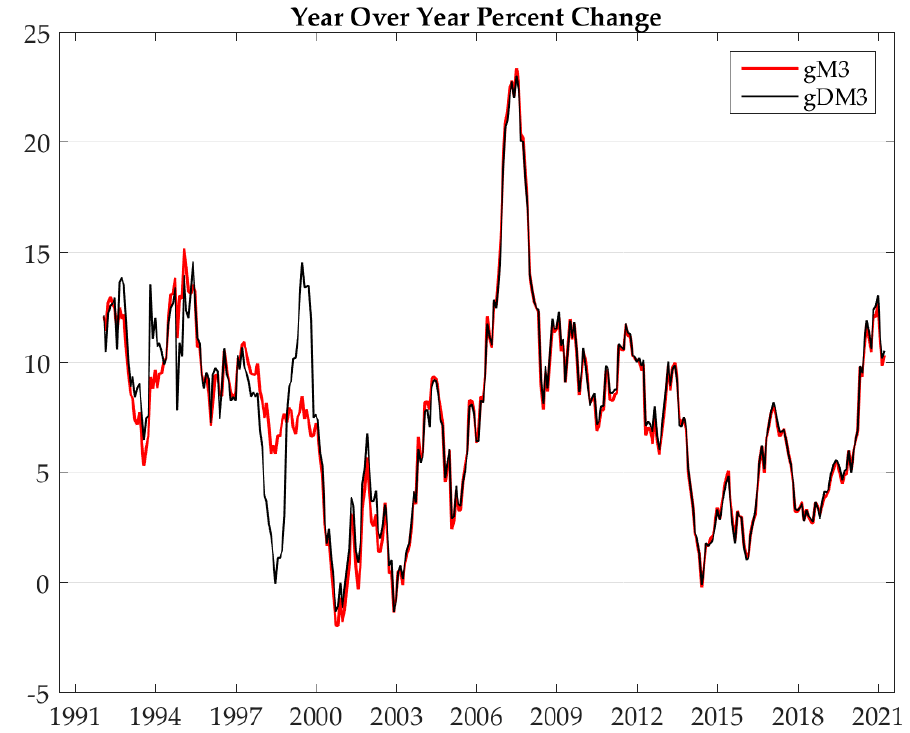
Figure 4. Divisia M3 versus simple sum M3 growth rates 1992–2021. After 2000, the growth rates of the Divisia monetary aggregates and the simple sum versions are close to each other. Again, the reason is the behavior of interest rates in Singapore. After 2000, interest rates for fixed deposits and savings deposits in both commercial banks and finance companies are at very low levels, almost zero, and thereby very similar to each other (see Figure 1). As a result, the user cost prices for those assets are almost identical to each other, so that the Divisia indexes are close to their simple sum counterparts during that period. In the future, simple sum and Divisia measures will again diverge, if interest rates return to higher levels.